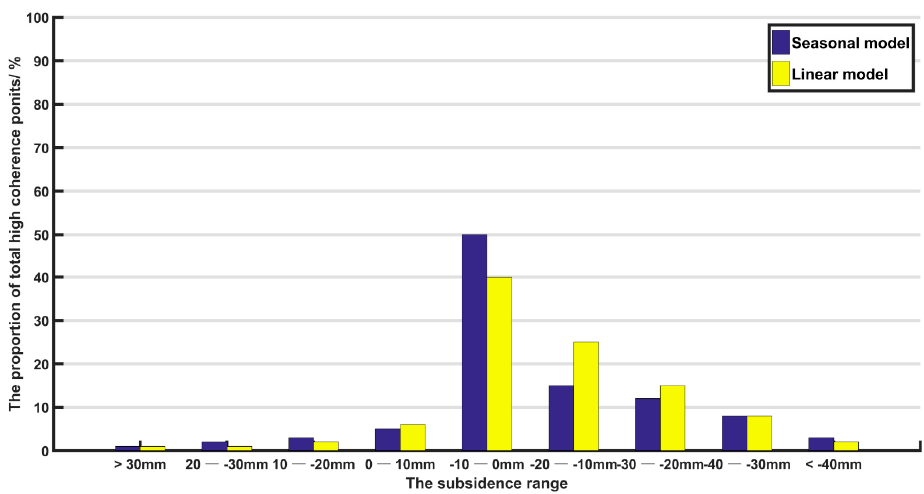
Figure 11. The magnitude distribution of settlement points in Lungui Road from 27 October 2014 to 27 November 2015 ( x axis defines each deformation interval; y axis defines the proportion of total high coherence points).